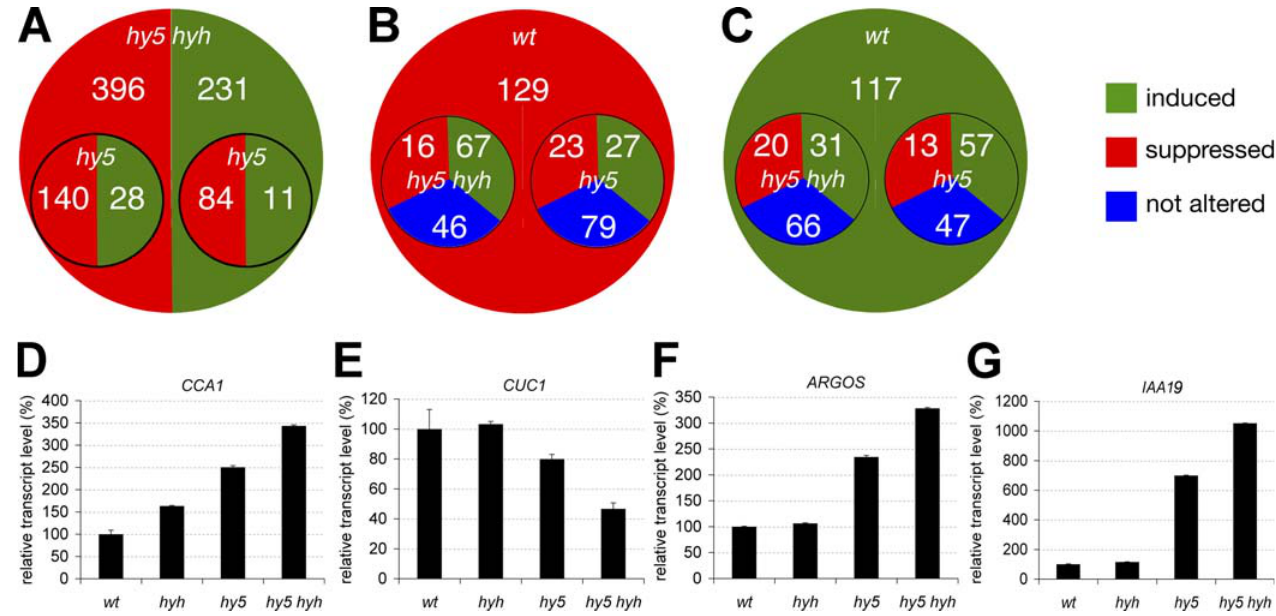
Figure 5. Transcriptome Analysis of hy5 and hy5 hyh Mutants (A) Total number of genes consistently underexpressed or overexpressed in hy5 hyh seedlings when compared to wild-type. The inlaid circles represent the subset of genes that are already affected in the hy5 mutant, with underexpression or overexpression compared to wild-type. (B) Subset of the genes presented in (A) that are repressed by auxin application in wild-type. The inlaid circles represent the auxin response of this set of genes in hy5 or hy5 hyh . (C) Subset of the genes presented in (A) that are induced by auxin application in wild-type. The inlaid circles represent the auxin response of this set of genes in hy5 or hy5 hyh . Red indicates underexpressed in (A) and repressed in (B) and (C). Green indicates overexpressed in (A) and induced in (B) and (C). Blue in (B) and (C) indicates genes that are not auxin responsive any longer in the mutant genotypes. (D–G) Confirmation of the expression levels of the indicated representative genes in replicate samples used in (A) by qPCR quantification. Transcript quantity is expressed relative to the control gene EF1 .